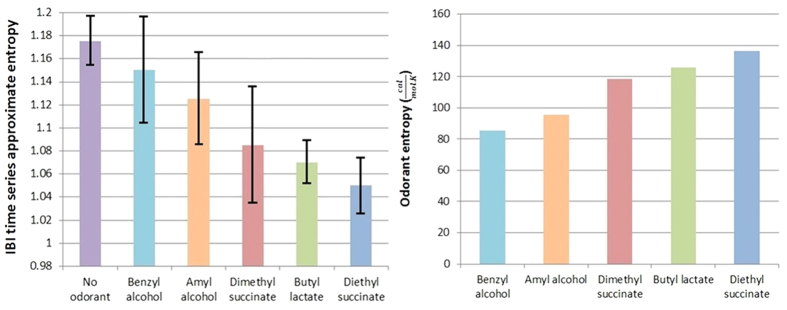
IBI time series approximate entropy in case of different odorants (on the left side), and the odorants’ entropy (on the right side).Error bars are standard deviations.